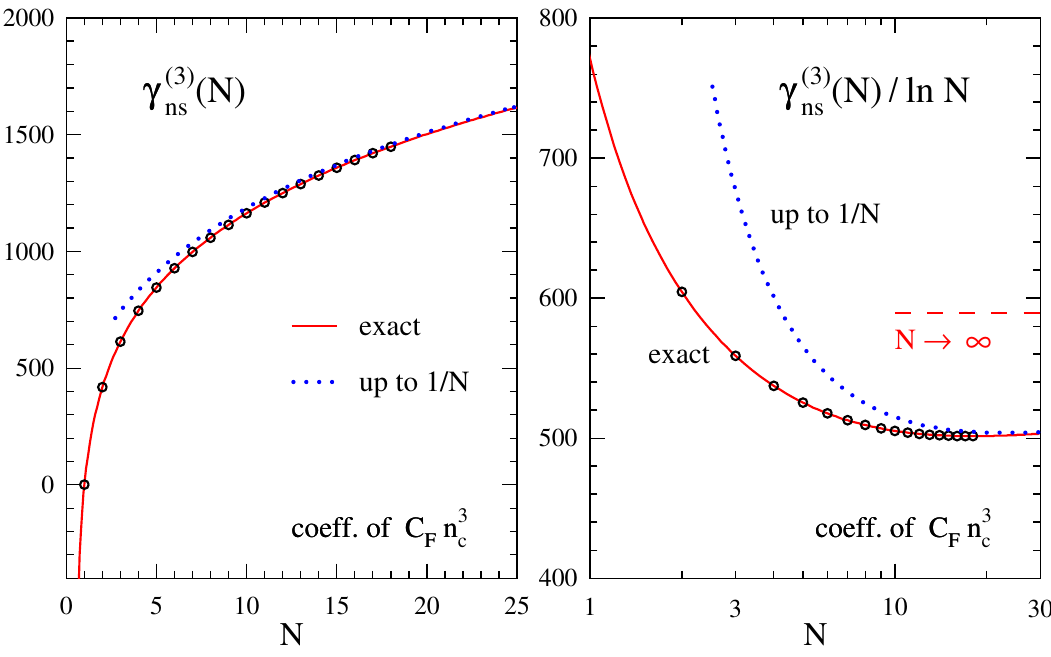
Figure 2 . The n 0 part (3.6) of the anomalous dimensions (cid:13) ( n ) (cid:6) ns ( N ) in the large- n c limit, compared f with its large- N expansion with all terms included in eq. (2.17) and, in the right panel, its asymptotic behaviour for N . The exact curve has been computed by via the x -space counterpart of ! 1 eq. (3.6), see section